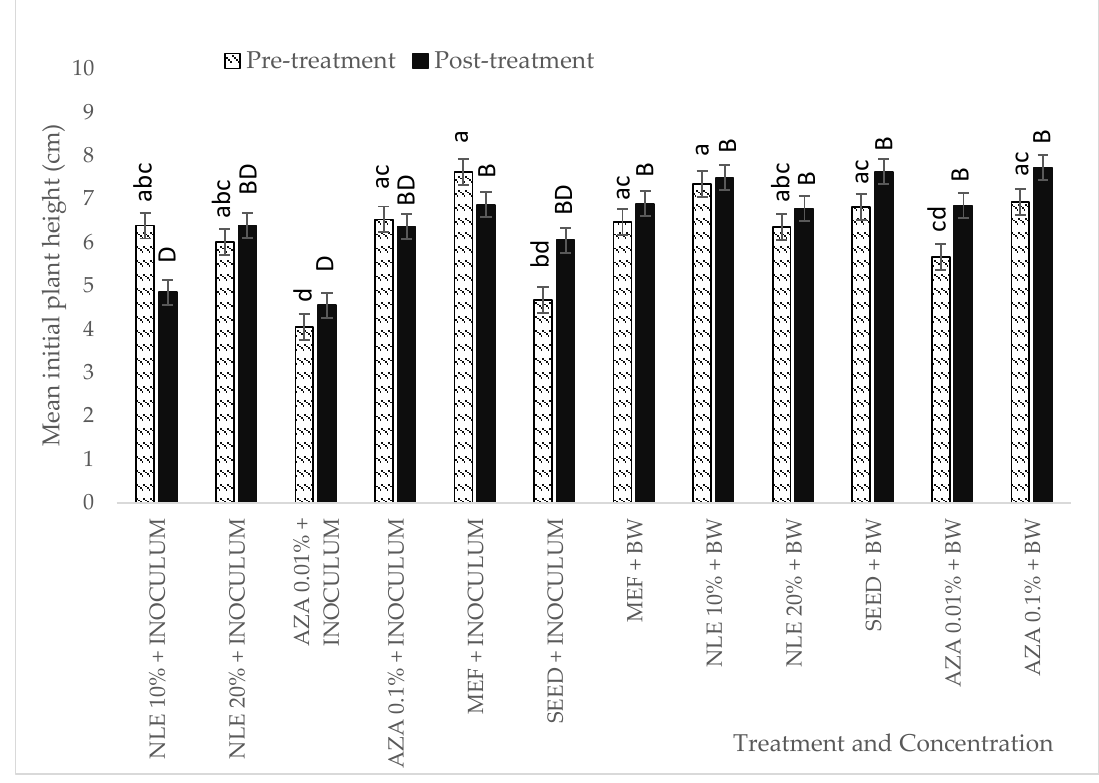
Figure 5. Measurement of initial plant height of seedlings pre- and post-treated with different concentrations of neem leaf extract (NLE) and NeemAzal T/S (AZA), and with bidistilled water (BW) serving as negative control, as a part of first evaluation. ANOVA post-hoc Tukey test was performed on the data. Different lowercase letters represent significant difference comparing the pre-treatment effect. Different uppercase letters represent significant difference to compare post-treatment effect according to Tukey's test at 95% confidence level .